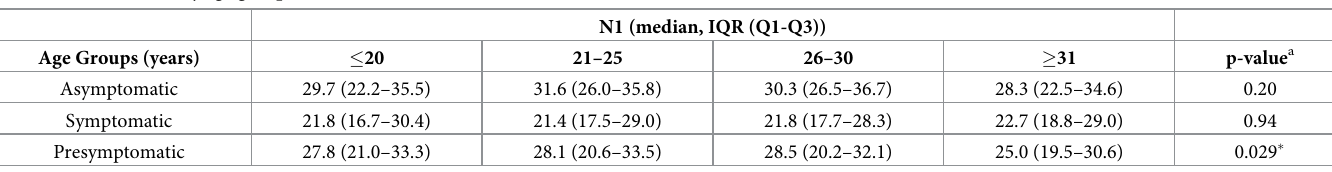
Table 3. N1 C T values by age group.